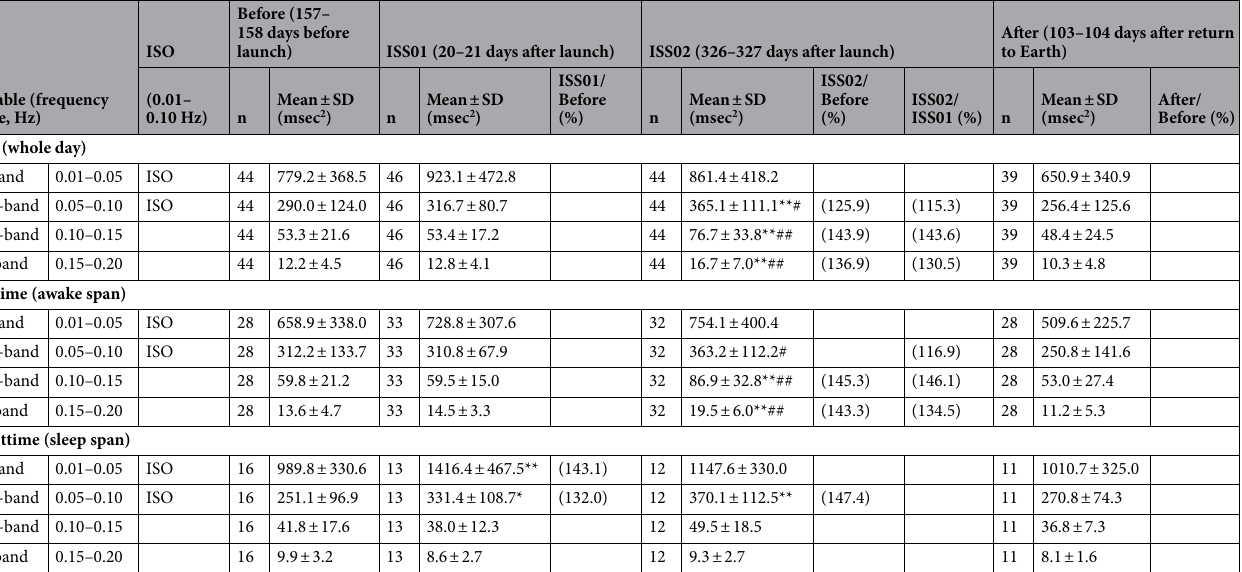
Table 3. Changes in heart rate variability reflecting the Default Mode Network as a function of time spent in space ‡. ISO: Infraslow Oscillation. ‡ Tests applied on hourly averages of 5-min intervals in order to eliminate or at least reduce serial correlation. *P < 0.05; **P < 0.01: ISS01, ISS02 or After vs. Before ; #P < 0.05; ##P < 0.01: ISS02 vs. ISS01 P-values from Student t-test; SD = standard deviation. |β|: slope of fractal scaling, corresponding to periods of 120 to 0.83 min, reflecting the intrinsic autonomic regulatory system. n: number of hourly averages (of 5-min intervals).